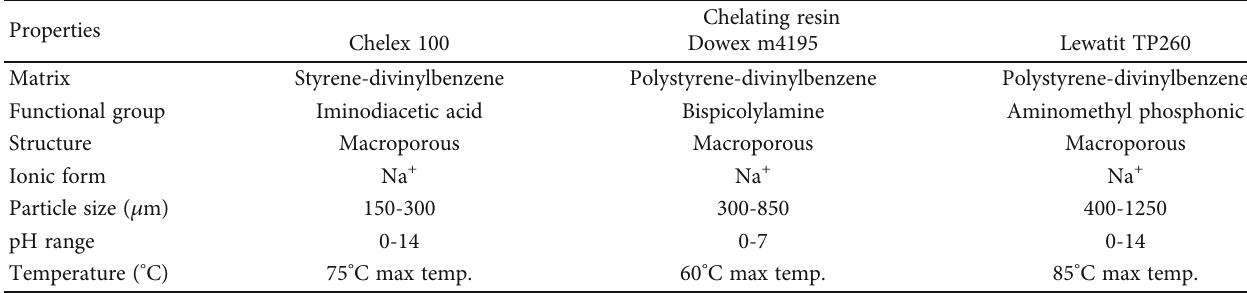
Table 1: Characteristics and properties of Chelex 100, Dowex m4195, and Lewatit TP260 chelating resins.